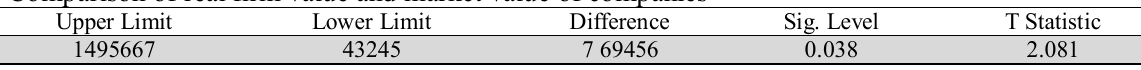
Comparison of real firm value and market value of companies Upper Limit Lower Limit